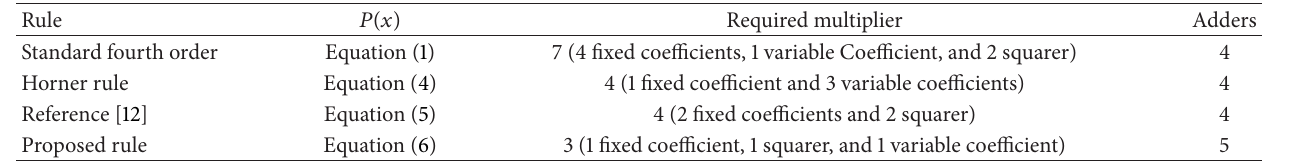
Table 3: Comparison on different polynomial arrangement.